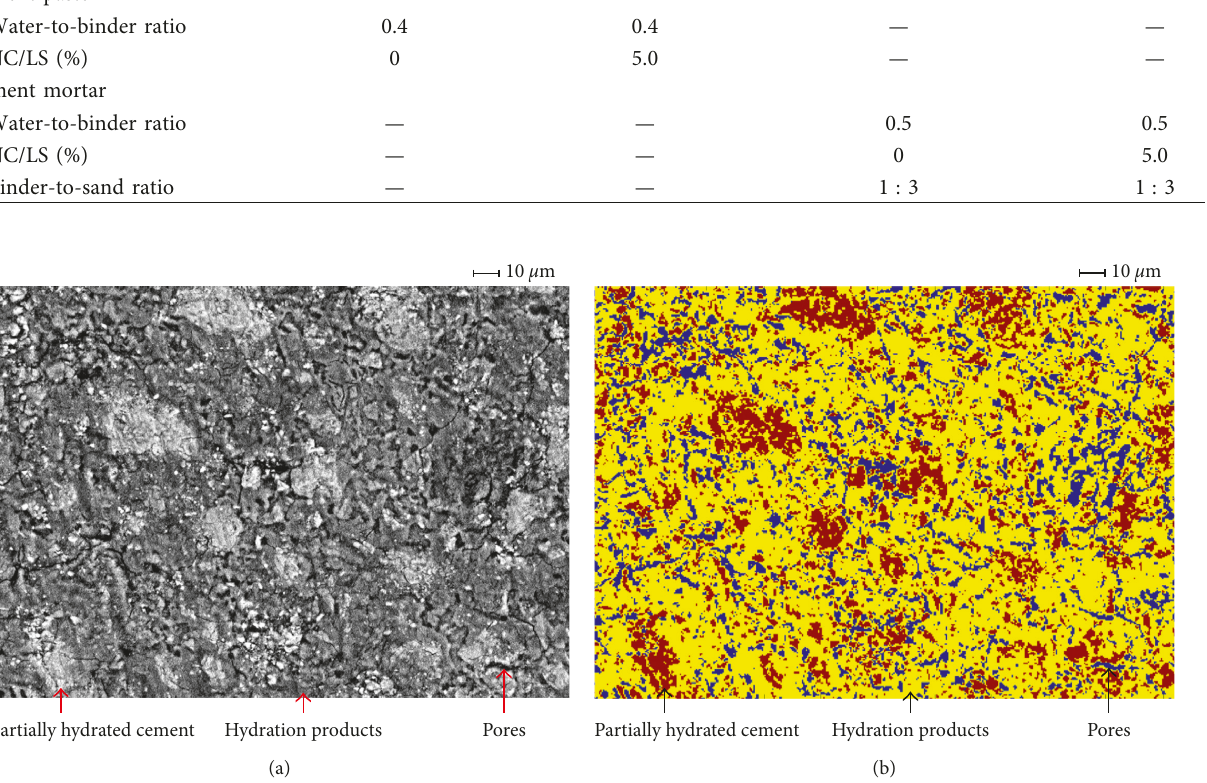
Figure 5: Cluster analysis of partially hydrated cement, hydration products, and pores. (a) A typical BSE image of C-0. (b) Results of cluster